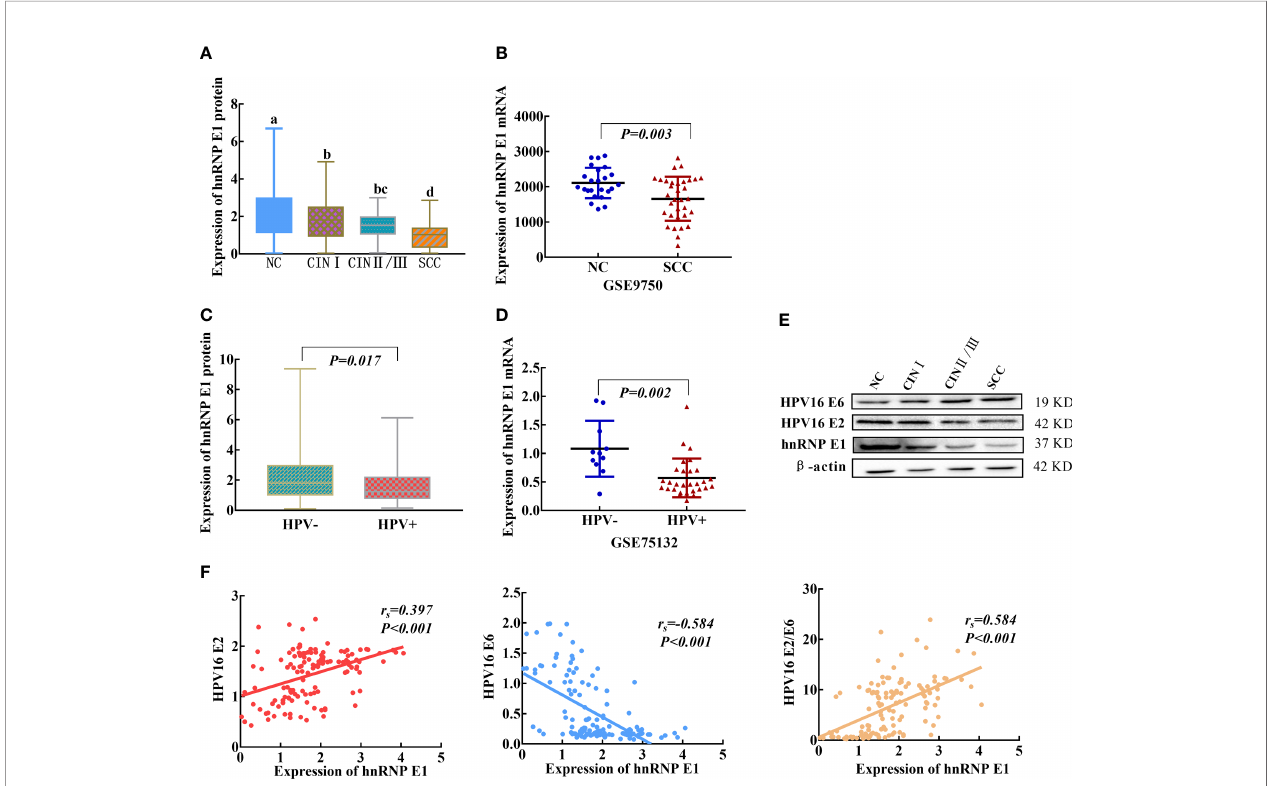
FIGURE 2 | hnRNP E1 expression and correlations with HPV16 E2 and E6 in cervical lesions. (A) hnRNP E1 protein expression levels in the clinical samples. (B) The hnRNP E1 mRNA expression levels in NC and SCC samples, data were obtained from GEO dataset. (C) The hnRNP E1 protein expression levels in HPV+ and HPV- samples. (D) The hnRNP E1 mRNA expression levels in HPV+ and HPV- samples, data were available from GEO dataset. (E) hnRNP E1, HPV16 E2 and E6 expression levels was detected using western blotting in cervix tissues. b -actin was used as loading control. (F) Correlations between hnRNP E1, HPV16 E2 and E6 in cervical lesions. a/b/c/d, different letters indicate signi fi cant differences at least P < a ’ ( a ’ =0.05/6 = 0.0083). HPV+ represents HPV-positive samples, and HPV- represents HPV-negative samples.